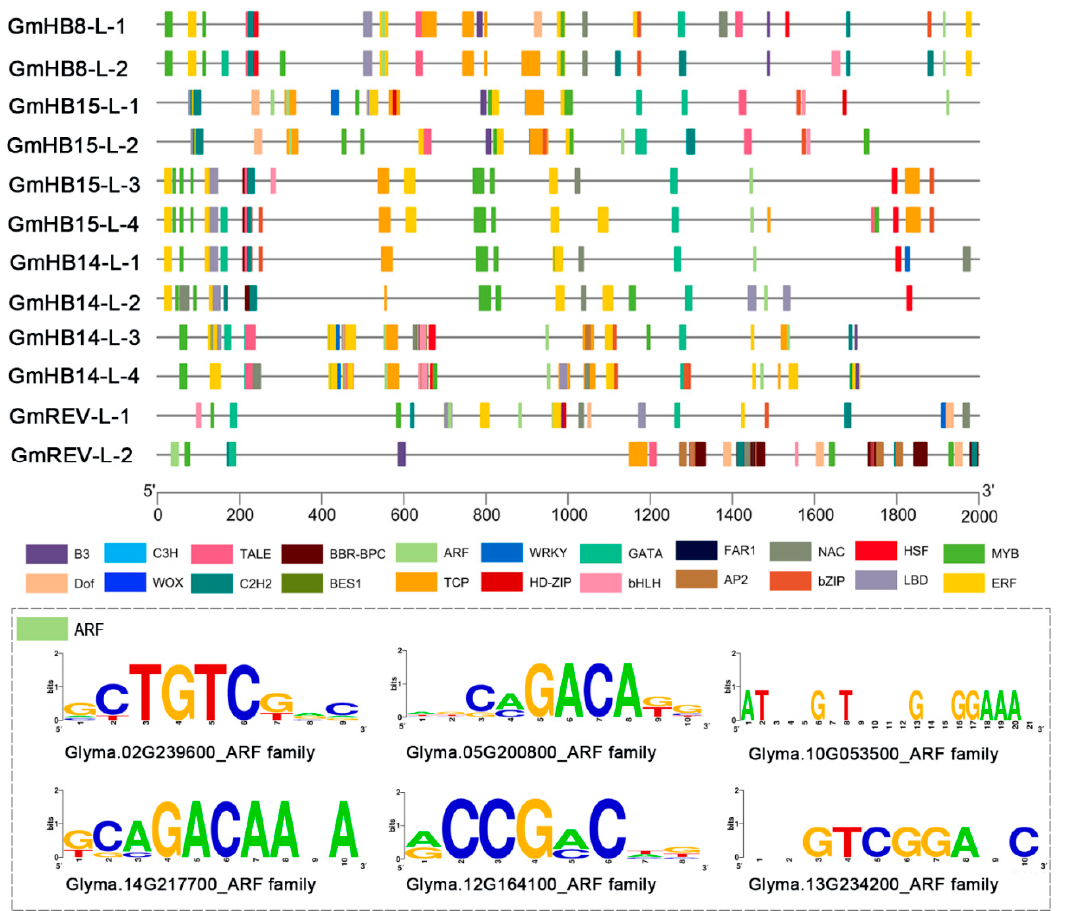
Figure 3. Analysis of cis -acting elements in the promoter regions of GmHD-Zip III genes.